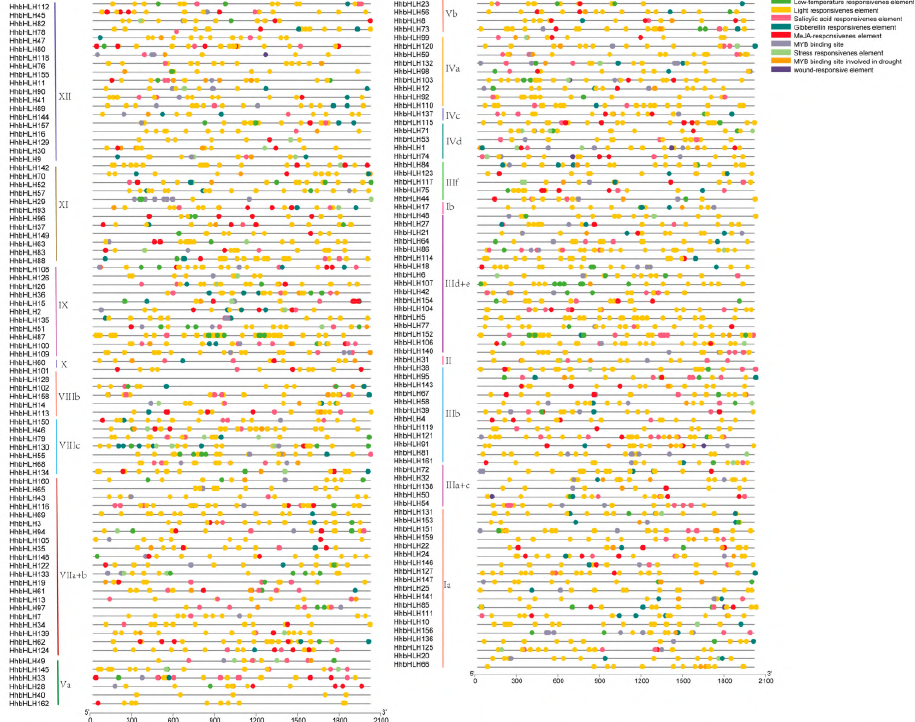
Figure 6. Analysis of the promoters of 162 bHLH genes in H. hamabo using cis -element analysis. Different hues denoted substances associated with plant hormones (salicylic acid, gibberellin, and methyl jasmonate) and stress resiliency (light, low temperature, wound-responsive, and drought